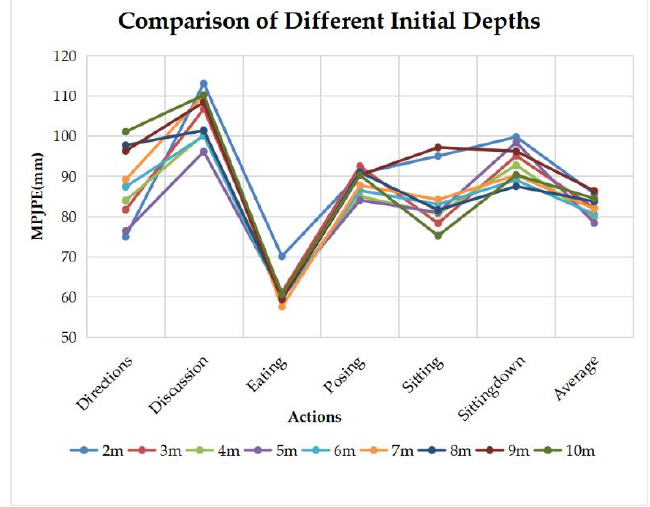
Figure 18. Comparison of different supposed initial depths.